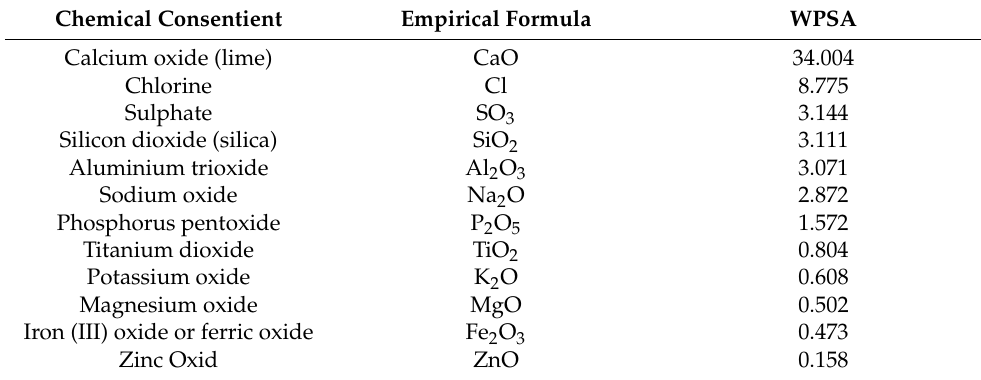
Table 2. XRF analysis for Wastepaper Sludge Ash (WPSA).